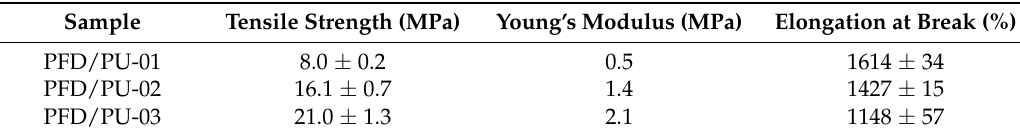
Table 6. Tensile properties of PFD/PUs.